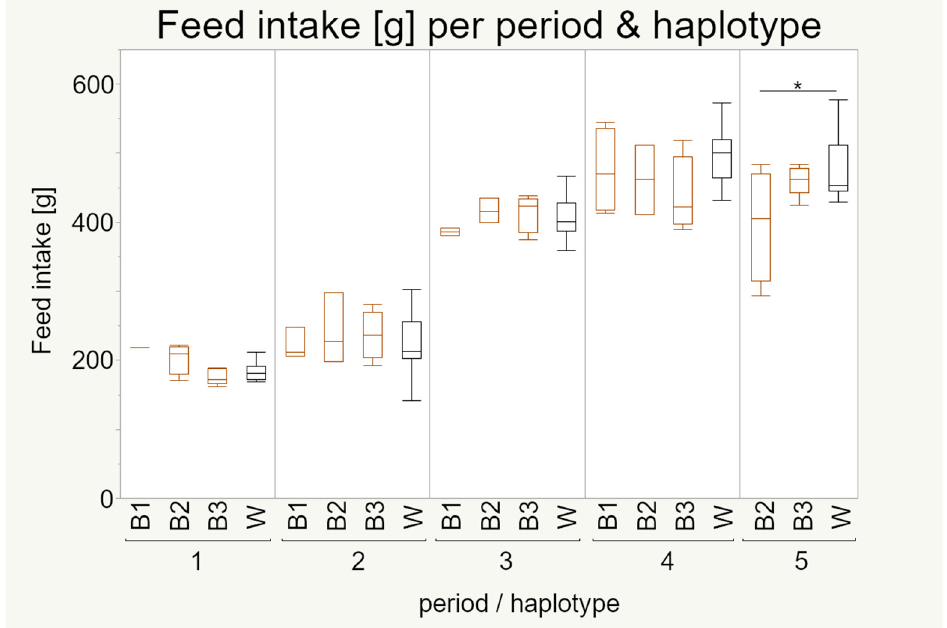
Figure 8. Feed intake (g) of 100 laying hens by haplotype and period. Boxes represent 50% of the data points (median with interquartile ranges) whiskers show minimum and maximum. Pairwise Tukey–Kramer HSD (for normal distributed data) or Steel–Dwass (for nonnormal distributed data) tests were used to test for significance within each period. Sample numbers are given in Table 3. Significance level * = p < 0.05. Feed intake was first studied by Sommerfeld et al. 2020a [27] in the context of strain differences.